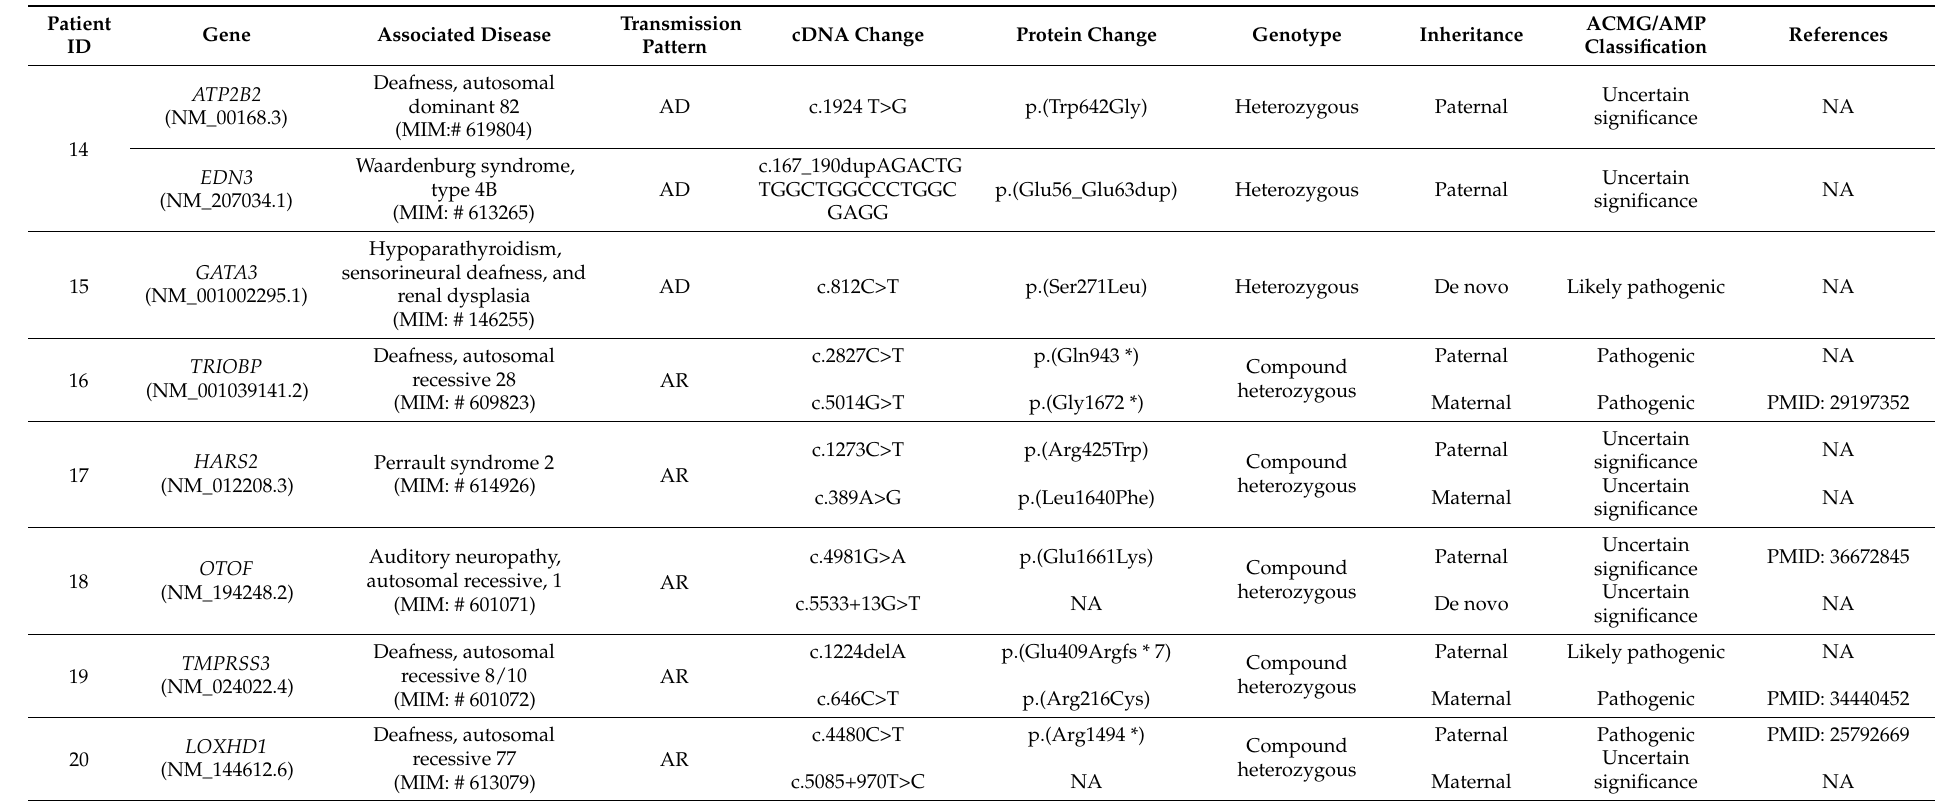
Table 3. Variants identified through WES analysis in apparent NSHL patients. Gene: list of genes carrying the identified variants with NCBI RefSeq accession number of the considered protein-coding transcripts (NM_). Associated disease: genetic disorder nomenclature according to the Online Mendelian Inheritance in Man ® (OMIM ® ) database. Transmission pattern: AD: autosomal dominant; AR: autosomal recessive. cDNA change and Protein change: variant description according to the Human Genome Variation Society (HGVS) nomenclature guidelines. Genotype: homozygous: the same variant is present on both alleles; heterozygous: the variant affects only one allele; compound heterozygous: two different variants are present on each allele. Inheritance: inheritance pattern of every identified variant established after parental segregation. ACMG/AMP classification: variant pathogenicity according to ACMG/AMP guidelines. References: PubMed unique IDentifier (PMID) of publications reporting each variant. *: stop codon. NA: not